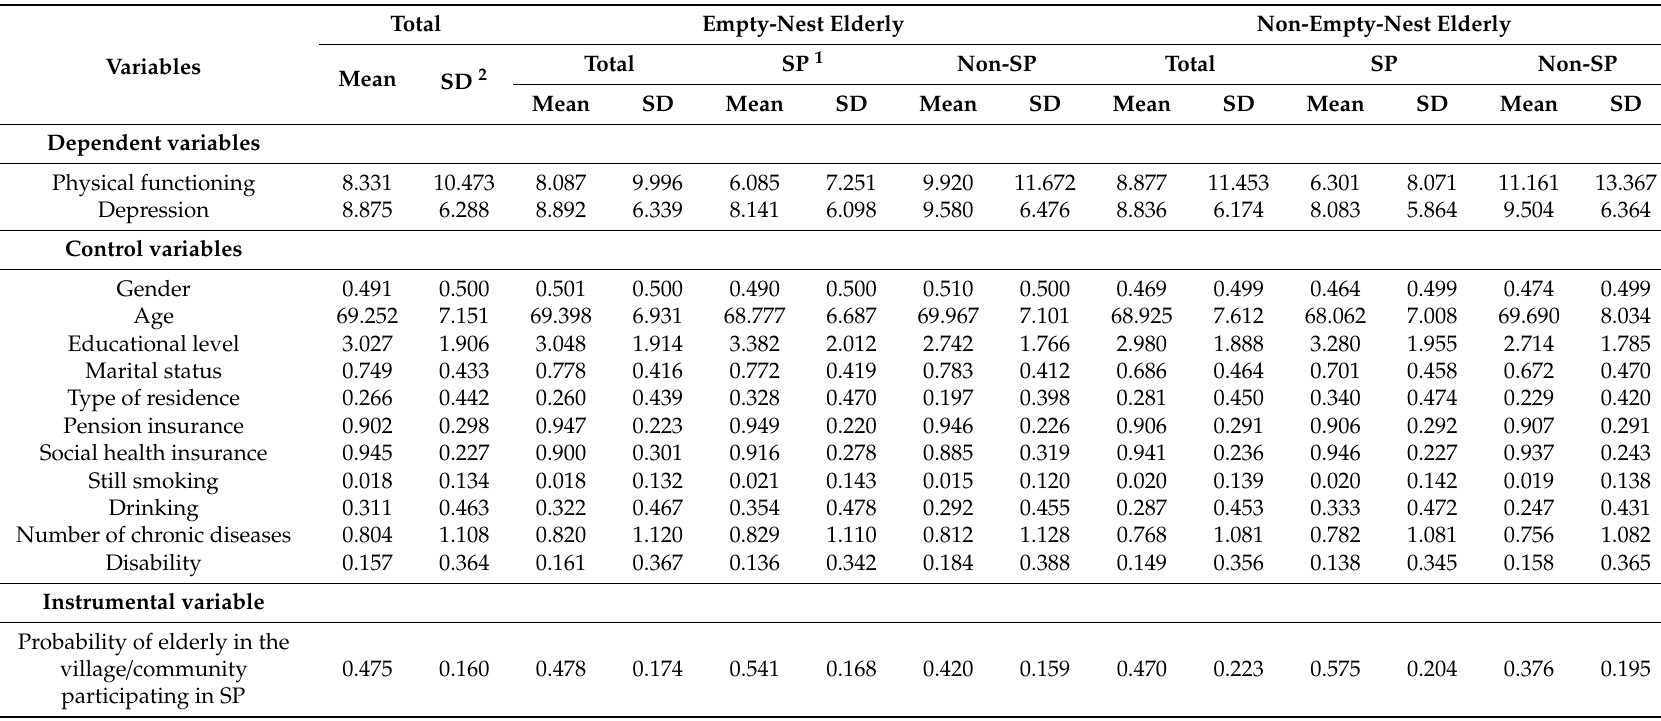
Table 1. Sample characteristics, CHARLS